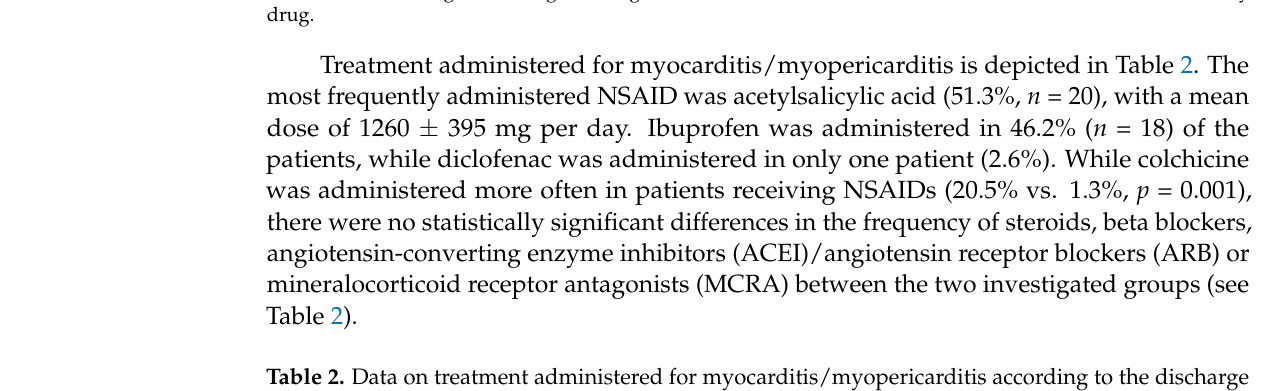
Table 2. Data on treatment administered for myocarditis/myopericarditis according to the discharge letter.